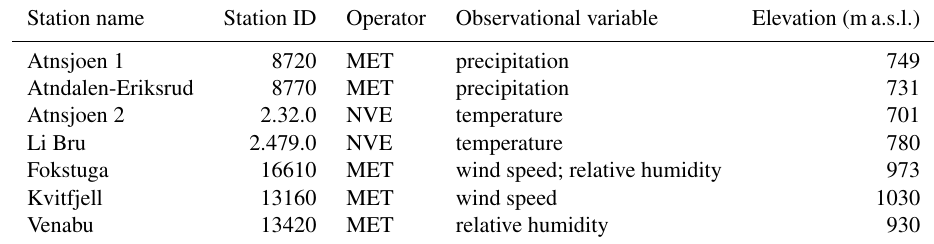
Table 1. Information about observational stations. Station name Station ID